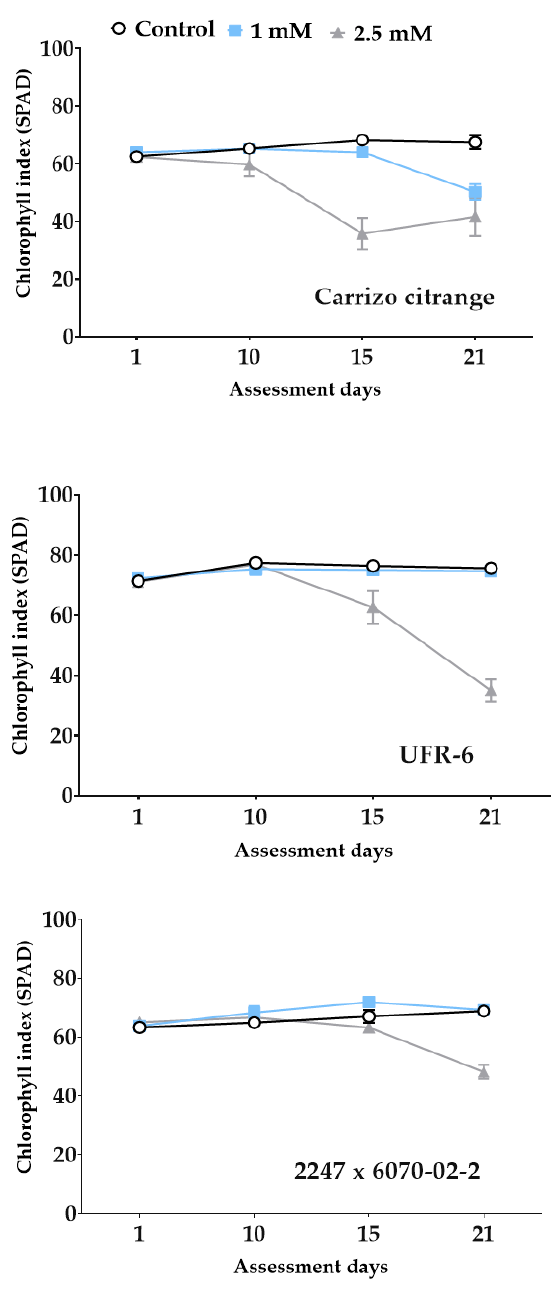
Figure 3. Time course for the mean of chlorophyll index values (SPAD) ± standard error (SE) with three treatments (Control, 1 mM H 3 BO 3 and 2.5 mM H 3 BO 3 ) on three different citrus rootstocks plants (Carrizo citrange, UFR-6 and 2247 x 6070-02-2) during twenty-one days of assessment.